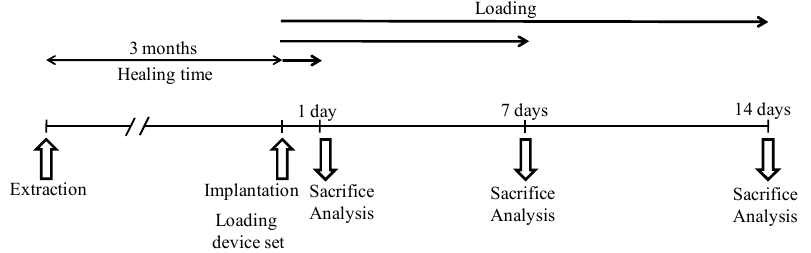
Fig. 1 Timeline of the